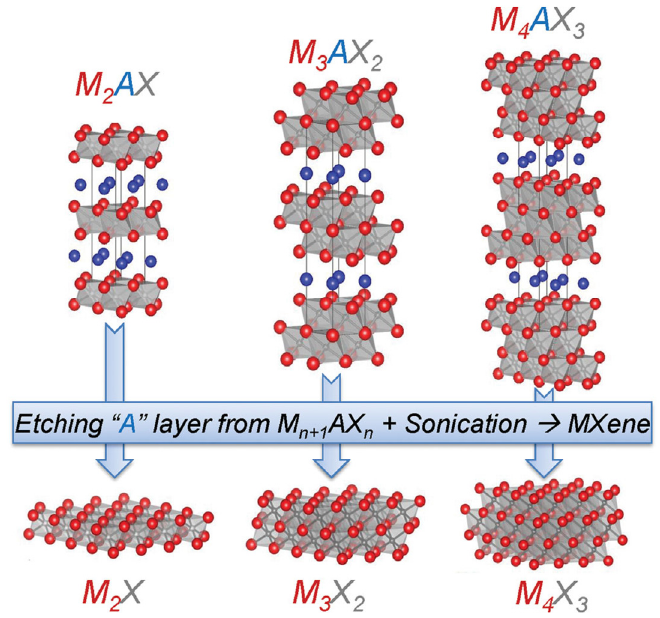
Figure 1. Structures of typical M 2 AX, M 3 AX 2 , M 4 AX 3 phases. Reprinted with permission from [8].